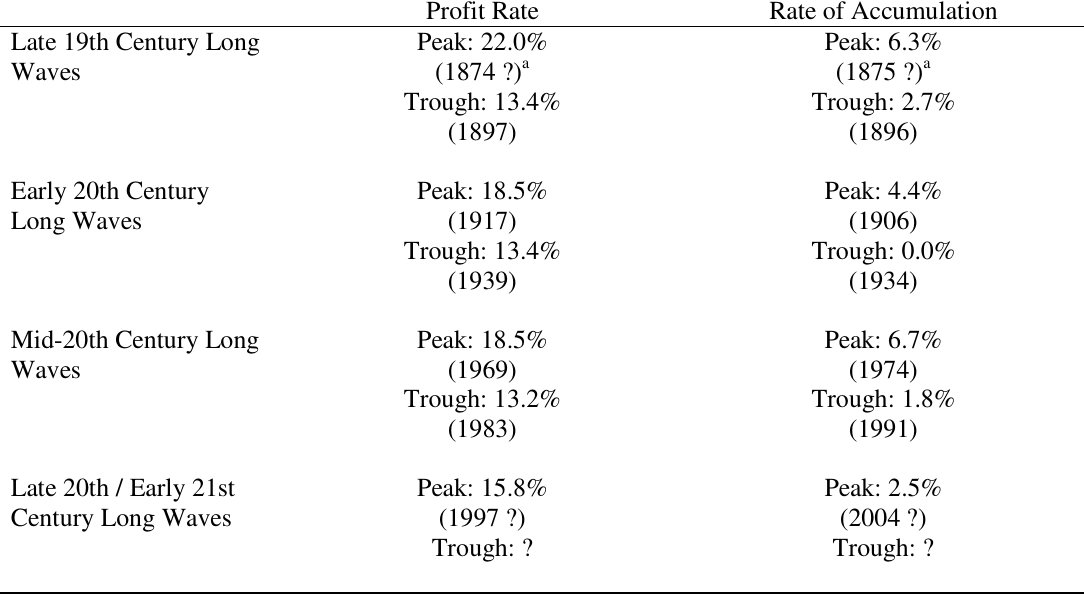
Table 2. The “World I” Profit Rate and Accumulation Long